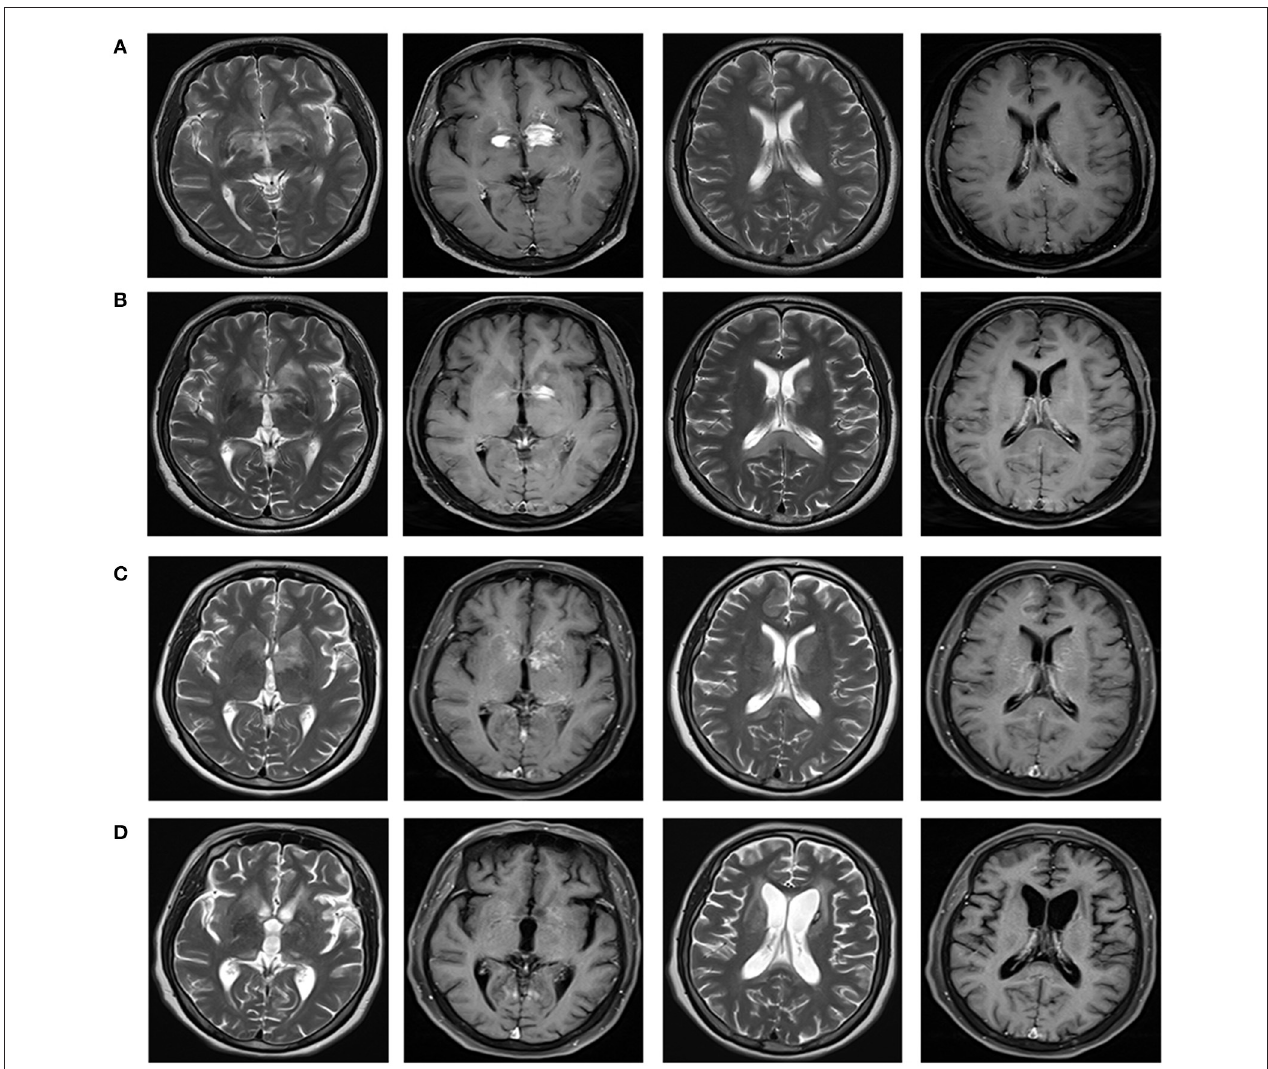
FIGURE 2 | Brain magnetic resonance imaging reflecting the imaging changes of lesions in bilateral basal ganglia and around the third ventricle, and the changes of splenial corpus callosum lesions during the course of disease. Brain MRI with T2-weighted and T1 contrast-enhanced were shown in different columns. (A) In December 2020, multiple abnormal enhancement lesions in bilateral basal ganglia and around the third ventricle were demonstrated. (B) In January 2021, lesions in bilateral basal ganglia and around the third ventricle reduced significantly with less enhancement. A new T2 signal in the splenium of the corpus callosum without enhancement was shown. (C) In March 2021, lesions in bilateral basal ganglia and around the third ventricle were the same as before, with increased enhancement. Attenuated T2 signal abnormality in the splenium of the corpus callosum was observed. (D) In August 2021, lesions in the bilateral basal ganglia and around the third ventricle significantly reduced, with complete resolution of the enhanced lesions. Abnormal signal foci in the splenium of the corpus callosum disappeared.